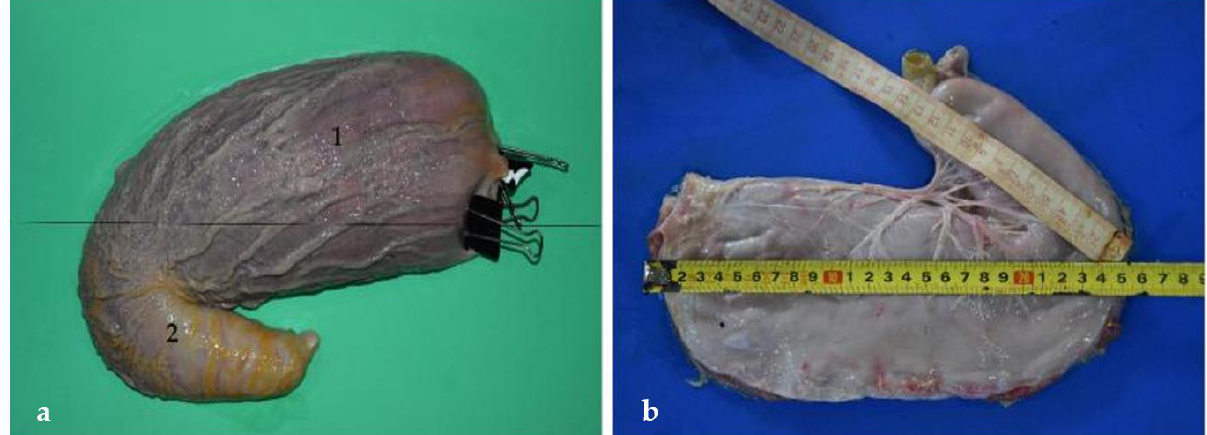
Figure 7. Stomach isolated from the abdominal cavity. ( a ) Anatomical pieces made up of expanded polyurethane (Fundación Mundo Marino) ( 1 ) Left part, ( 2 ) right or pyloric part.; ( b ) total length of the stomach or sum of the left and the pyloric parts (37 cm).